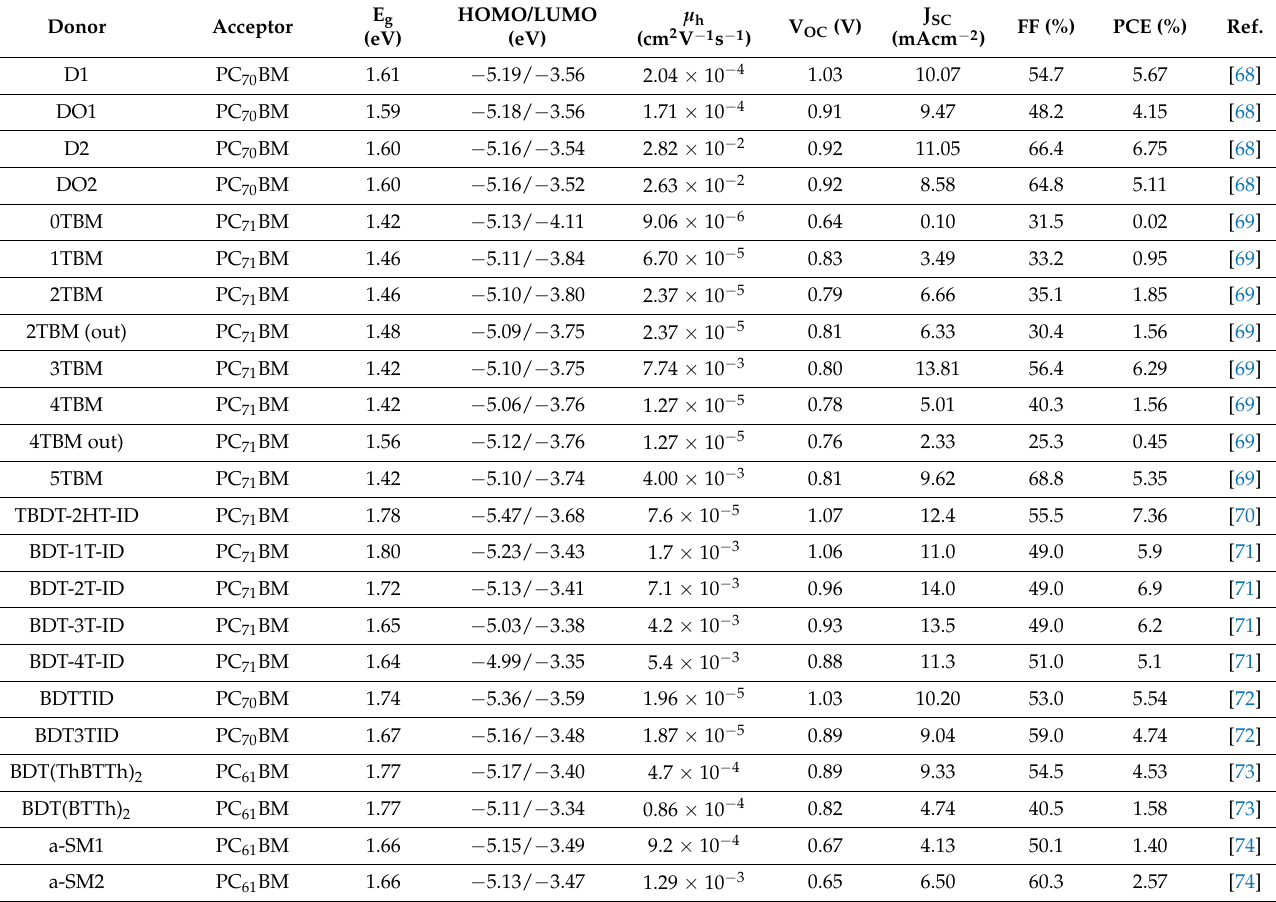
Table 3. Optoelectronic properties and device parameters for BDT-based ASM OSCs via π -bridge